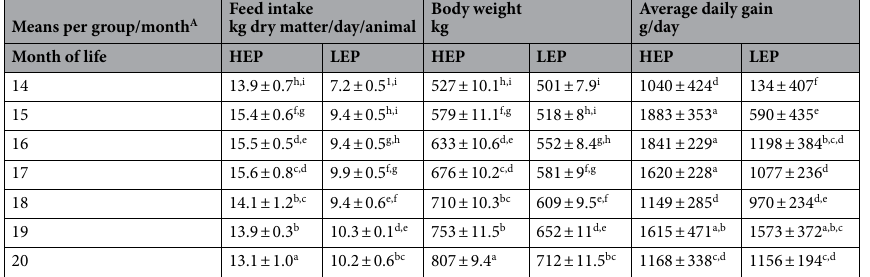
Means per group/month